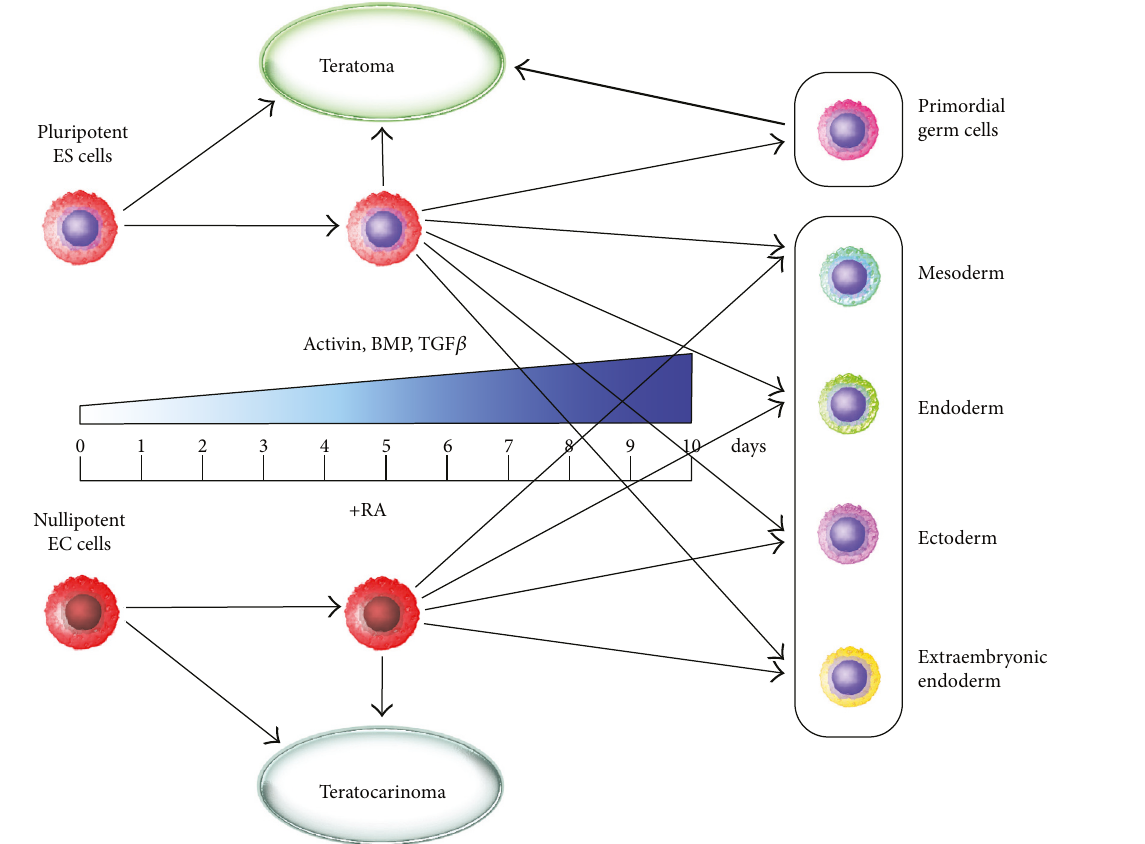
Figure 7: Tumorigenic and di ff erentiation potentials of ES R1 and EC F9 cells during the course of RA-induced di ff